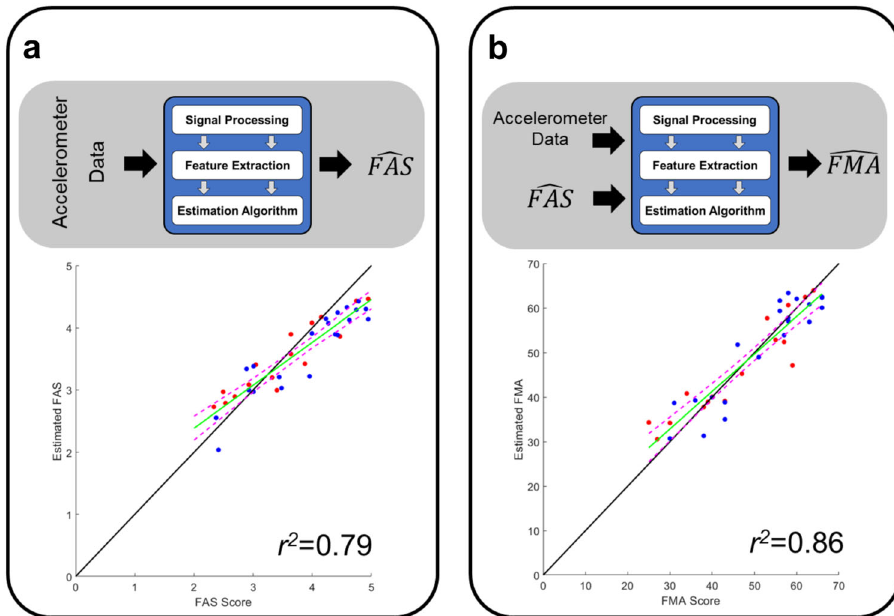
Fig. 3 Estimation of movement quality (FAS) and motor impairment (FMA) clinical scores. a Results obtained using a technique previously developed by our research team. b Results obtained using the proposed technique (i.e., balanced RF with FAS estimates as an additional input). Blue and red circles represent data collected from TBI and stroke survivors. The green line is the linear regression of the estimates; the magenta dashed lines are the con fi dence intervals around the estimation. FAS Functional Ability Scale, FMA Fugl-Meyer assessment, RF random forest, TBI traumatic brain